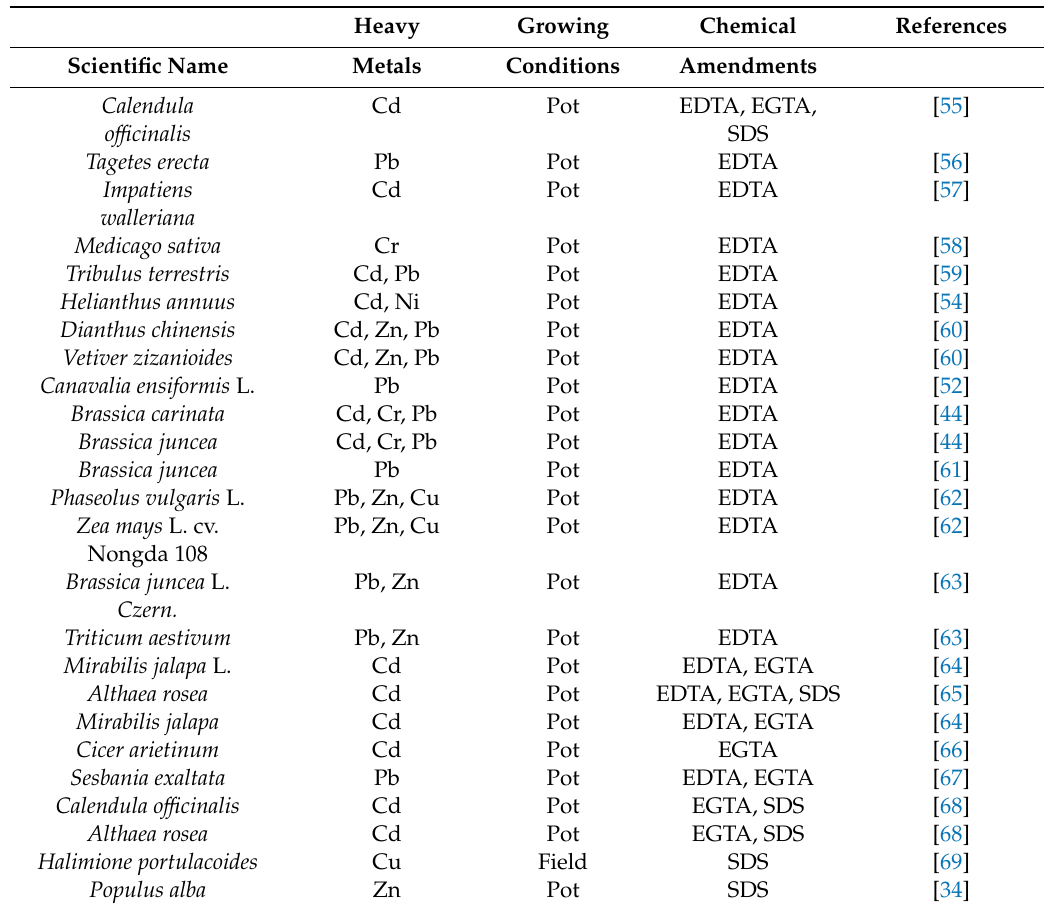
Table 1. E ff ects of heavy metals on the plants with di ff erent growing conditions along with chemical